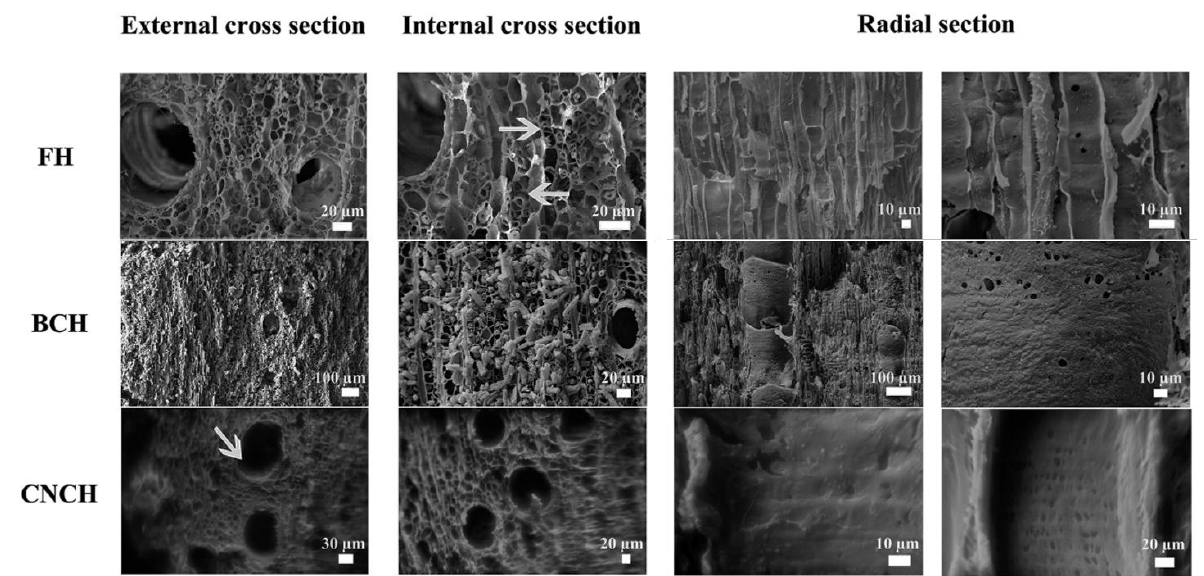
Figure 3. SEM images of freeze-dried control wood (FH) and blocks treated with bacterial nanocellulose (BCH) and cellulose nanocrystals (CNCH). External and internal sections: for FH cell, lumens are empty and secondary cell walls appear almost completely detached; for BCH sample, some of cell lumens are filled with consolidant, which creates sporadic superficial deposits; finally, for CNCH-treated wood, the cell lumens are empty and there is a thin layer of consolidant but it is not everywhere. Radial section: the fiber walls of sample FH appear smooth and the channels that they form are clearly visible; in BCH sample, there is a homogeneous and compact layer of consolidant, visible on the cell walls; in the CNCH sample, cellulose nanocrystals form a compact and homogeneous coat completely covering the pits. Reproduced under terms of the CC-BY license [18].